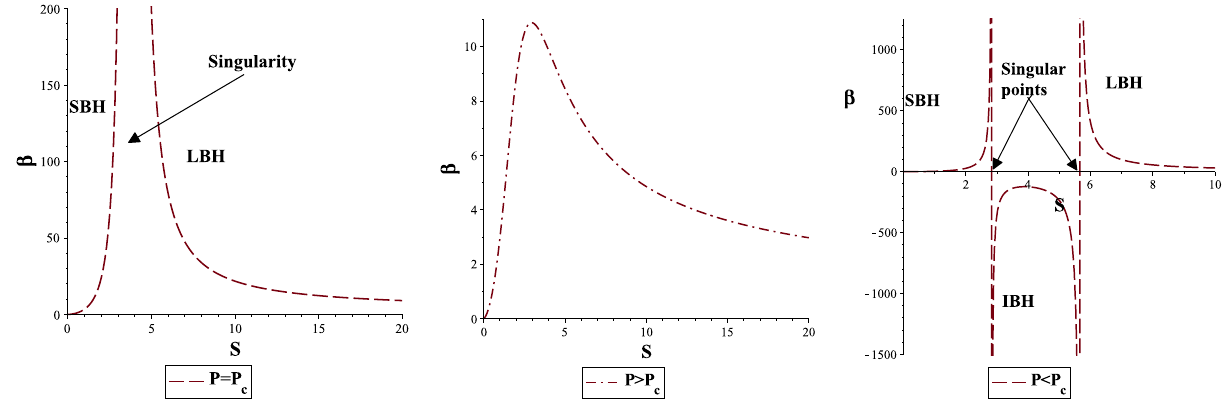
Fig. 12 β versus S with a 2 = 2, e = 0 . 2 and g = 0 . 6. Left panel: P = P c , middle panel: P > P c and right panel: P < P c